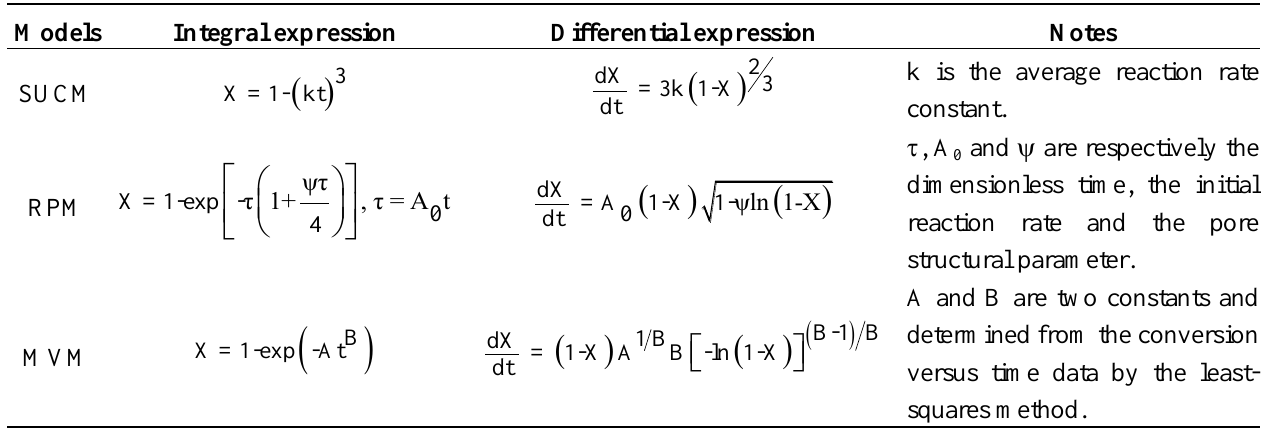
Table 1. Integral and differential expressions of SUCM, RPM and